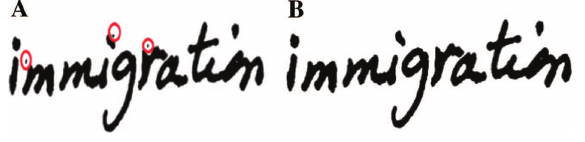
Figure 3: Word Instances (A) Before and (B) After Deletion of Small Components.